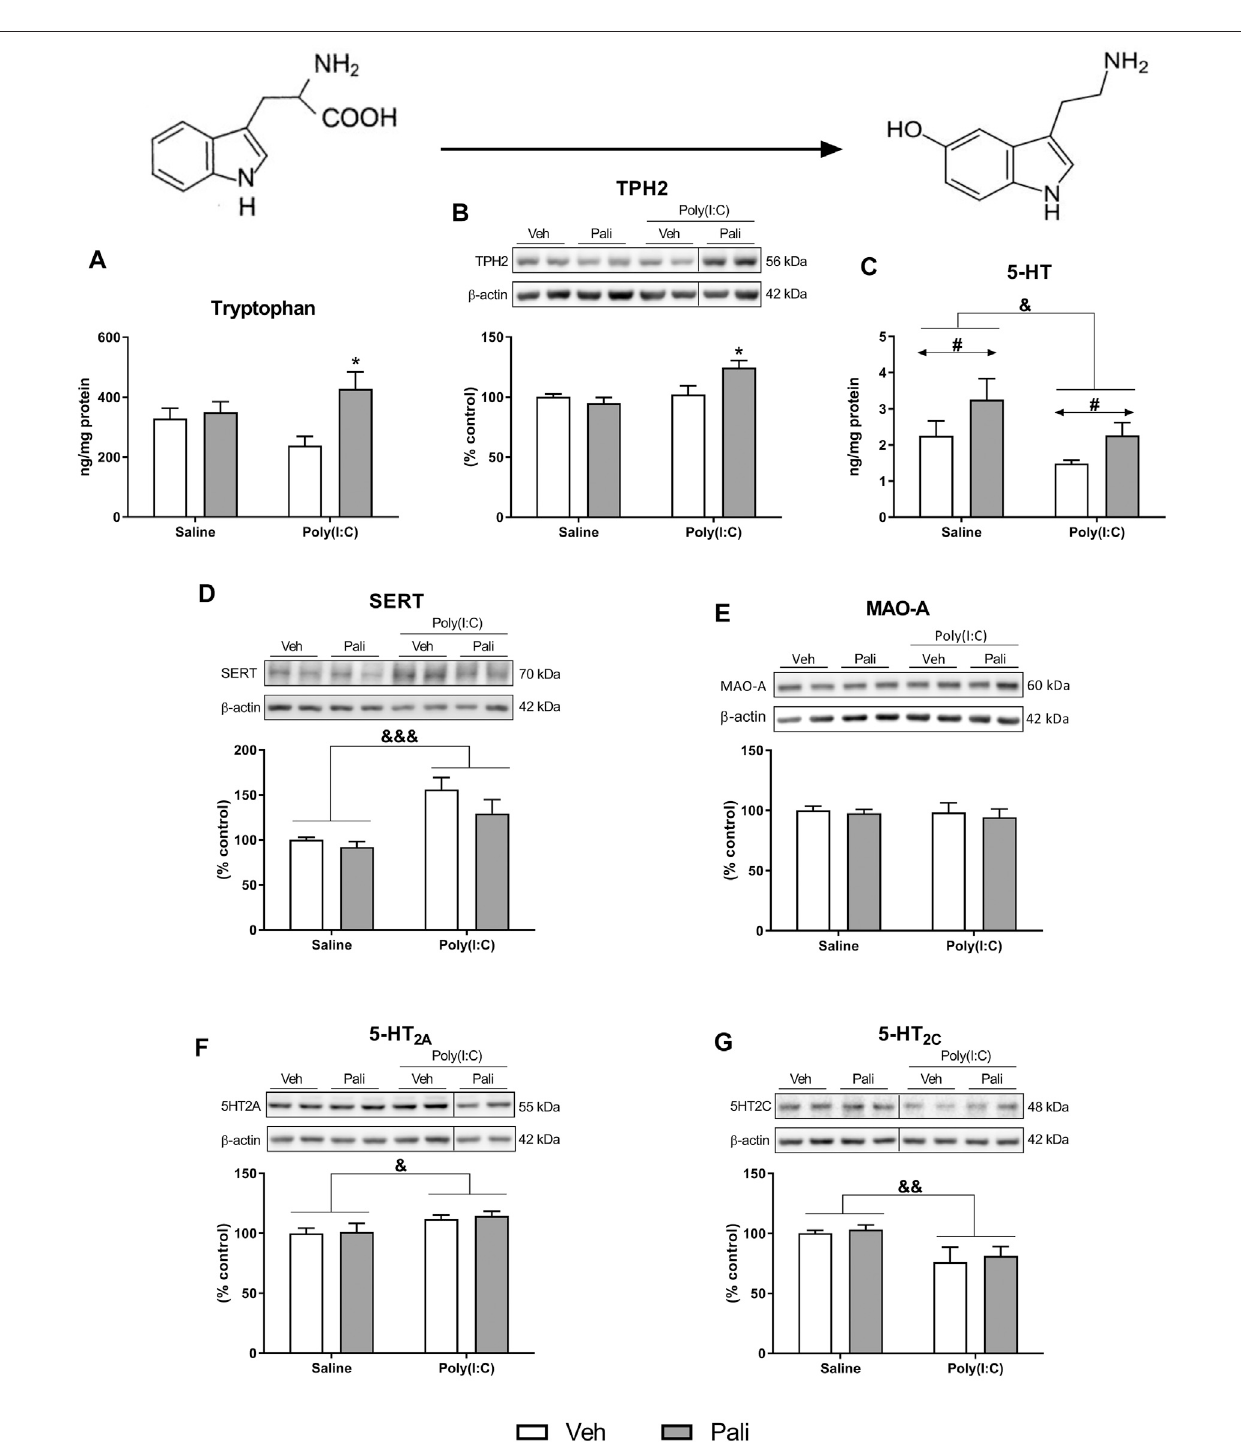
FIGURE 1 | Effects of paliperidone on 5-HT neurochemical processes after MIA in mice FC. Tryptophan levels (A) , protein expression of TPH2 (B) , 5-HT levels (C) and protein expression of SERT, MAO-A, 5-HT 2A and 5-HT 2C receptors (D – G) in the FC of mice treated with vehicle (Veh) or paliperidone (Pali) in control (Saline) and prenatalpoly (I:C)administration.Thedensitometricdataoftherespectiveimmunoreactive bandswerenormalizedby β -actin. Inthe (B,F,G) panels, blotswerecropped (blacklines)forimprovingtheclarityandconcisenessofthepresentation.Barsrepresentmeans ± SEM.Thenumberofexperimentsinallparametersanalyzedwas between 8-9 animals. Two-way ANOVA: & p < 0.05, && p < 0.01, &&& p < 0.001 for poly(I:C) factor; # p < 0.05 for treatment factor. * p < 0.05 vs poly (I:C)+Veh group (Bonferroni post hoc test after signi fi cant interaction).